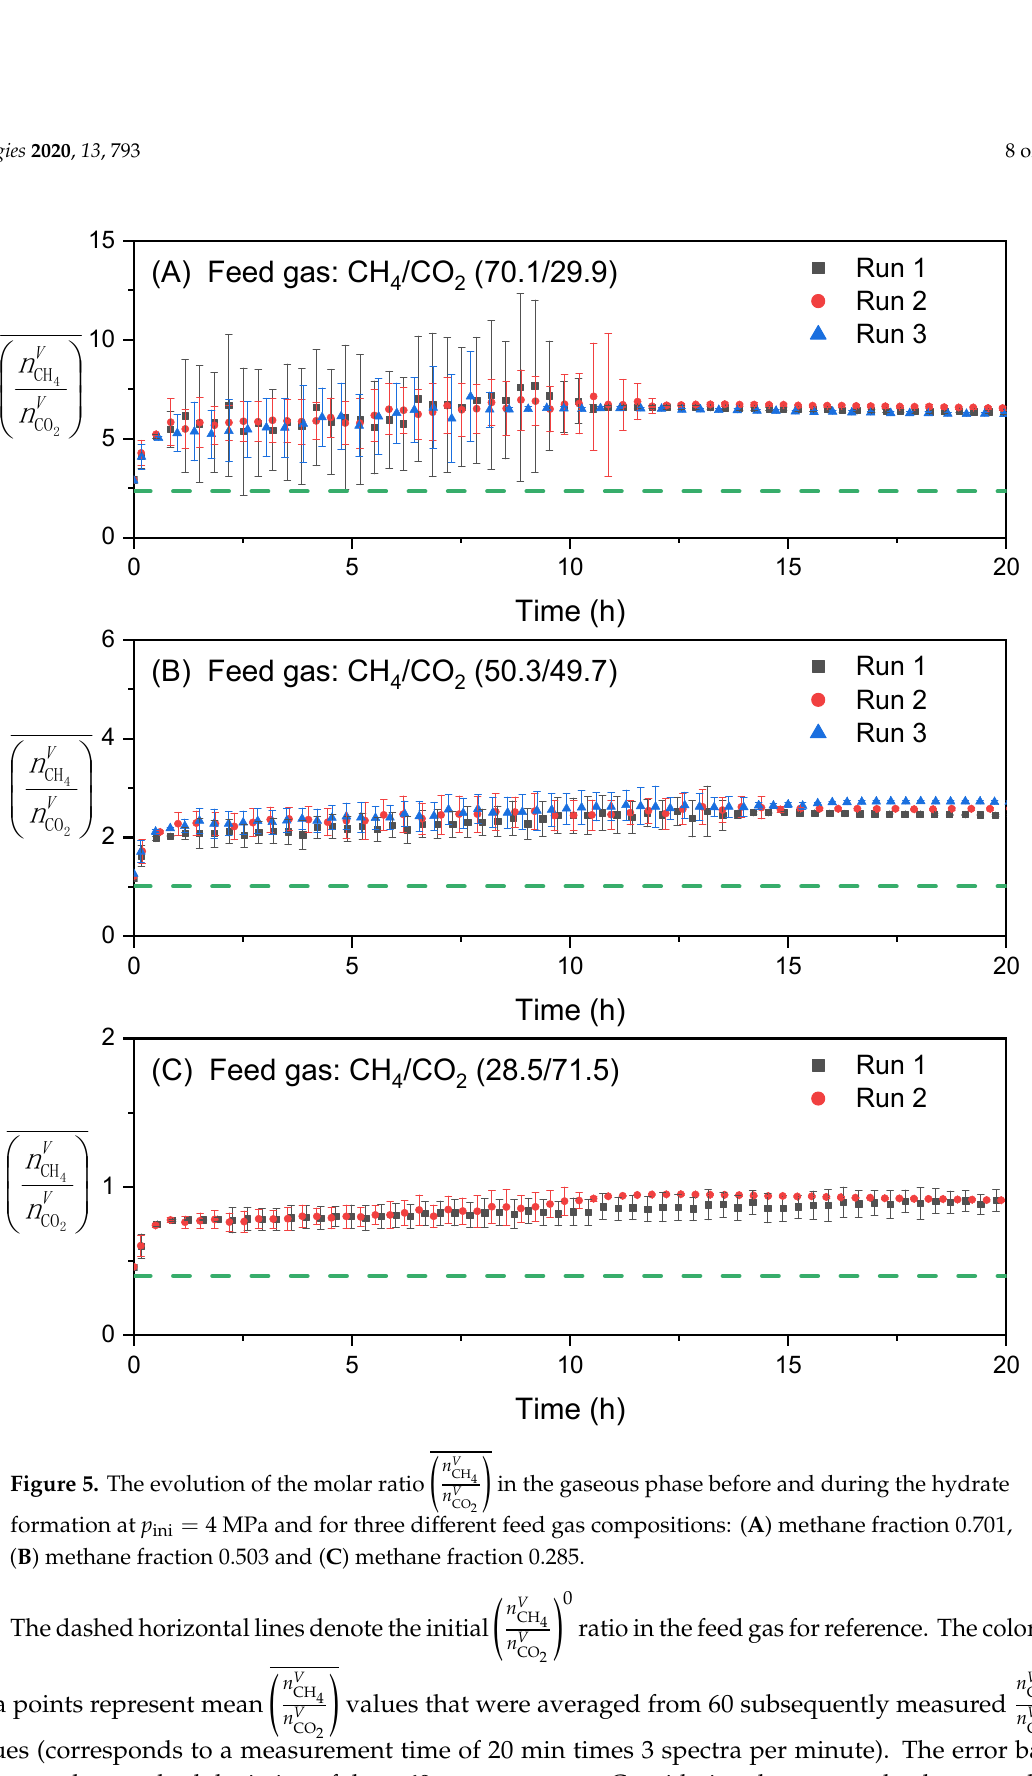
n V CH4 n V CO2